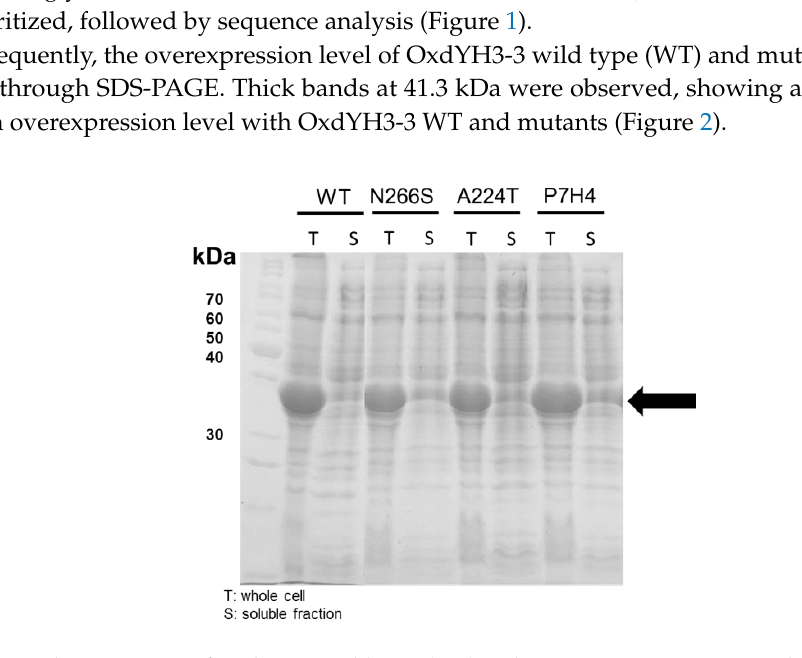
Table 1. The activity of OxdYH3-3 WT and mutants. The activities at 1 h toward 50 and 100 mM of E - 3-pyridine aldoxime and 2-furfuryl aldoxime were compared.